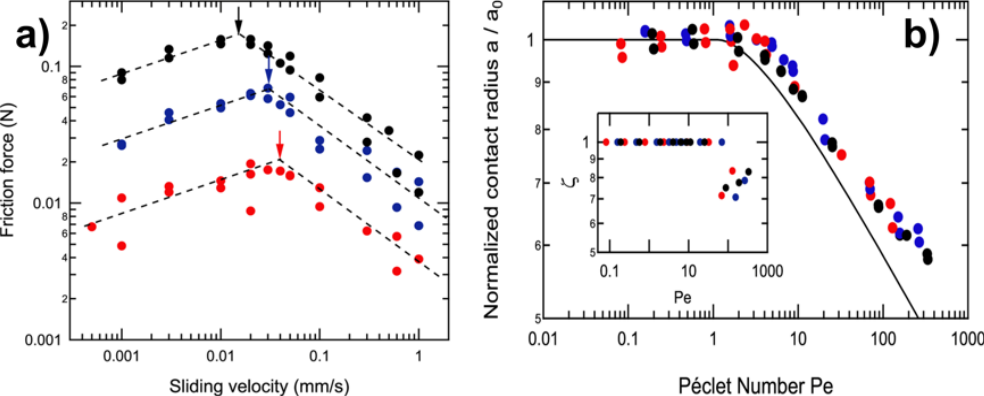
Figure 6. Decrease in friction and contact radius with increasing Peclet number due to the poroelastically driven flow in a hydrogel. ( a ) Friction as a function of sliding velocity for a thin poly(dimethylacrylamide) (PDMA) film coating a substrate fixed on a linear translation stage with a spherical glass probe as countersurface. The decrease in friction starts when the contact radius starts to decrease below that under static conditions, which happens when the Peclet number becomes larger than 1, as shown in ( b ). The inset in ( b ) shows changes in the asymmetry parameter ζ as a function of Pe. The black line in ( b ) corresponds to the prediction of the poroelastic model proposed in this work. Results at normal load of 50 mN (red), 200 mN (blue) and 600 mN (black). ( a , b ) Reproduced from Ref. [64] Copyright 2018 with permission from ACS publications.